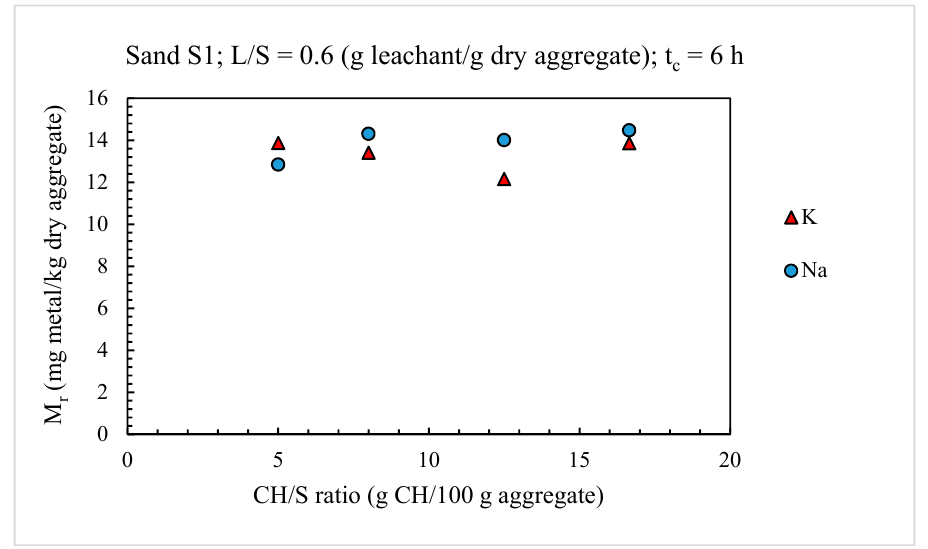
Figure 2. Effect of solid calcium hydroxide (CH)–to-dry aggregate (S) ratio (CH/S) on alkaline metal release from sand S1.